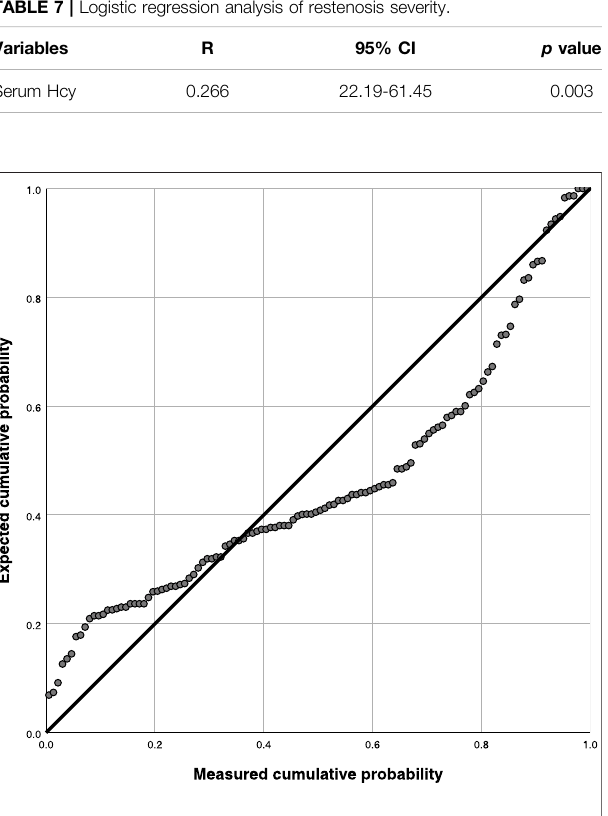
Frontiers in Pharmacology |